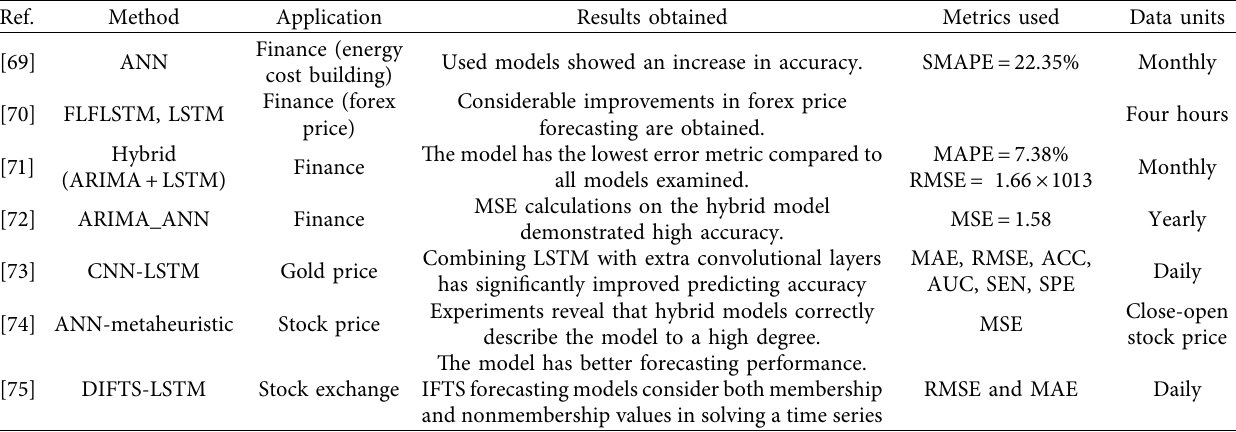
Table 4: A summary of published articles that used deep sequential models in finance and stock predictions.